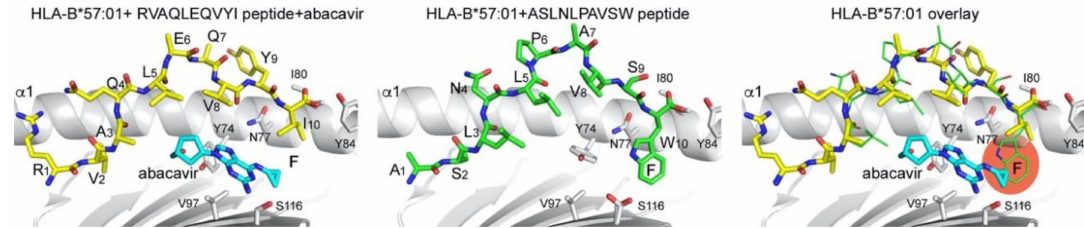
Figure 3. Abacavir modulation of peptide binding to HLA-B*57:01. Peptide (yellow and green sticks) and abacavir (cyan sticks) binding reveals di ff erences in the size of the F pocket. Overlay of two di ff erent peptides that bind to HLA-B*57:01 in the absence or presence of abacavir highlight how peptides with terminal Trp anchor residues are disfavored from binding together with abacavir, due to a steric clash (right panel). PDB 3VRI was used for the abacavir-containing structure and PDB 6V2O for the structure without abacavir. Overlay was generated by superimposing both HLA-B*57:01 molecules (grey